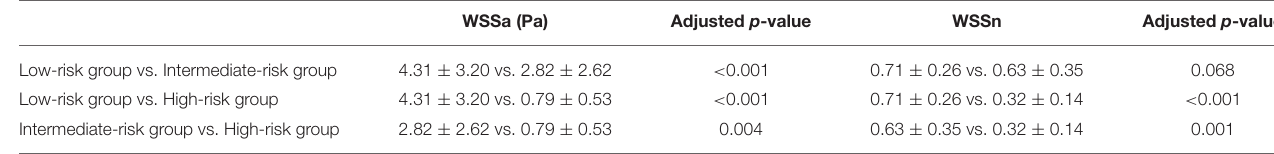
TABLE 3 | Multiple comparisons of aneurysmal wall shear stress among low-, intermediate-, and high-risk